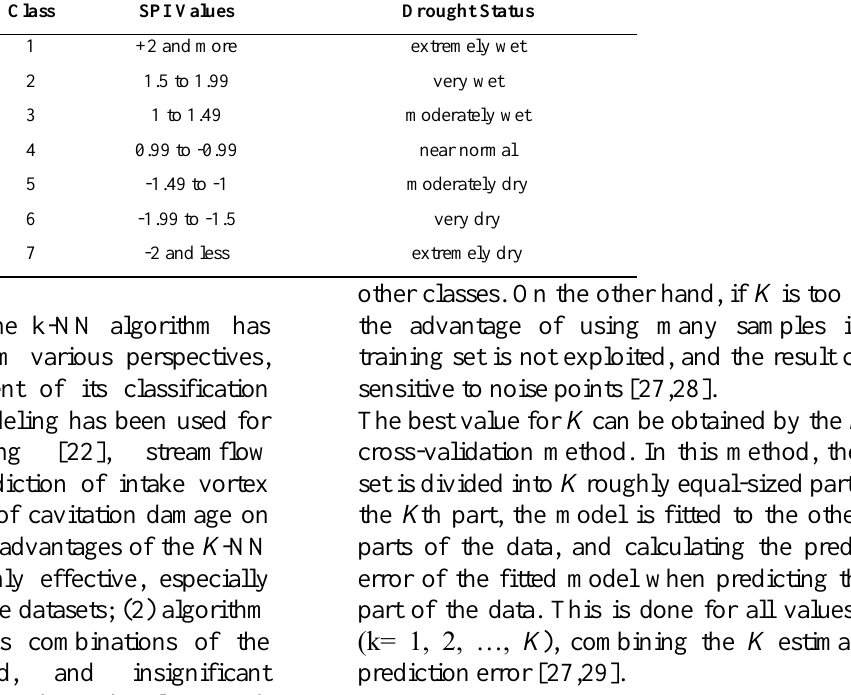
Table 1. Drought classification of SPI [9]. Class SPI